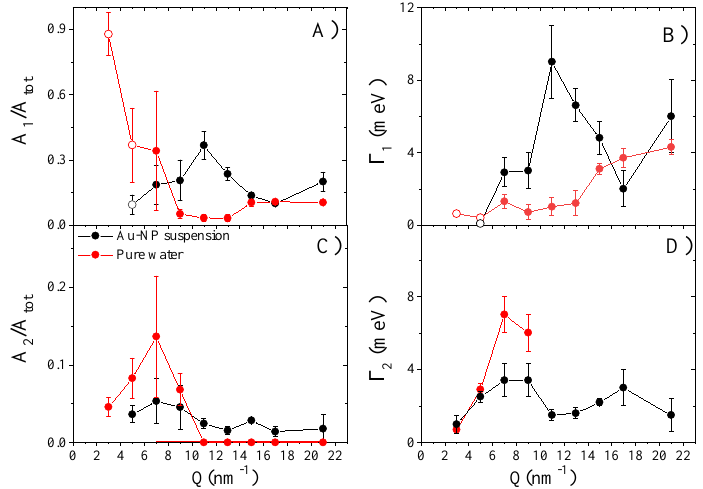
Figure 5. ( A ) displays, as a function of Q , the best-fit areas, A 1 of the low-energy inelastic profile, DHO 1 , normalized to the one of the whole spectrum, A tot ; ( B ) shows the halfwidth of the inelastic peaks, Γ 1 of the same DHO 1 excitation. Values reported in ( C , D ) are as those in ( A , B ), respectively, but in reference to the high-energy inelastic profile DHO 2 . The open circles label resolution-limited best fit values, as discussed in the main